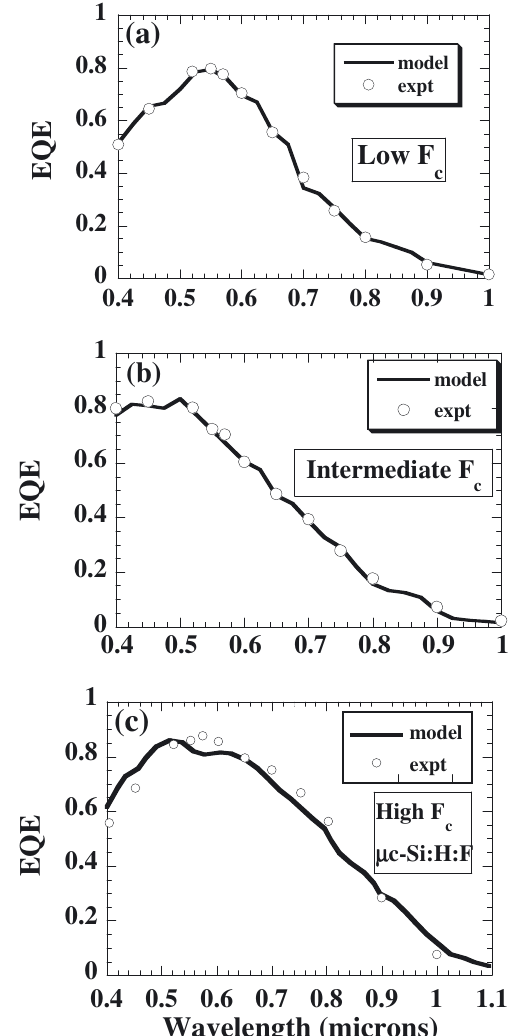
Fig. 5. Calculated external quantum efficiency (EQE) curves under AM1.5 bias light and short-circuit conditions for the (a) low F c μ c-Si:H cell A, (b) intermediate F c μ c-Si:H cell B and (c) high F c , large grained μ c-Si:H:F cell, compared to experimental